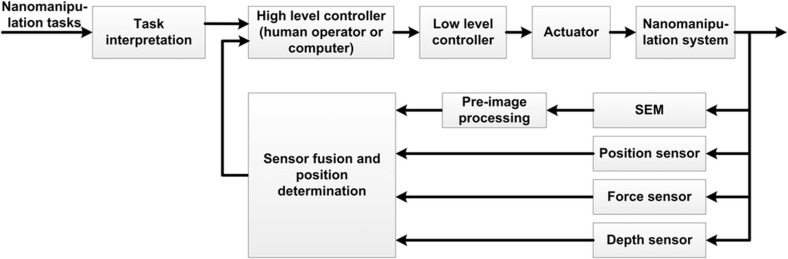
Control architecture of nanorobotic manipulation inside an SEM; scanning electron microscope.